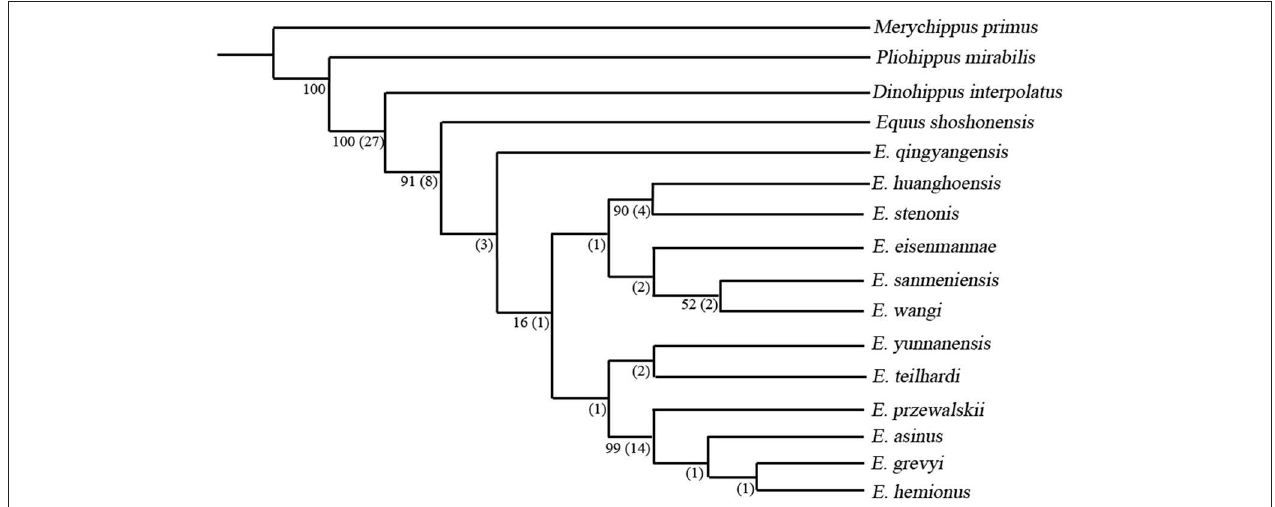
FIGURE 1 | Most parsimonious tree (MPT) obtained from phylogenetic analysis, Tree length = 148, consistency index = 0.635, retention index = 0.768. Numbers by the nodes denote the Bootstrap (outside brackets, not shown if value < 50) and Bremer values (in brackets, not shown if value <